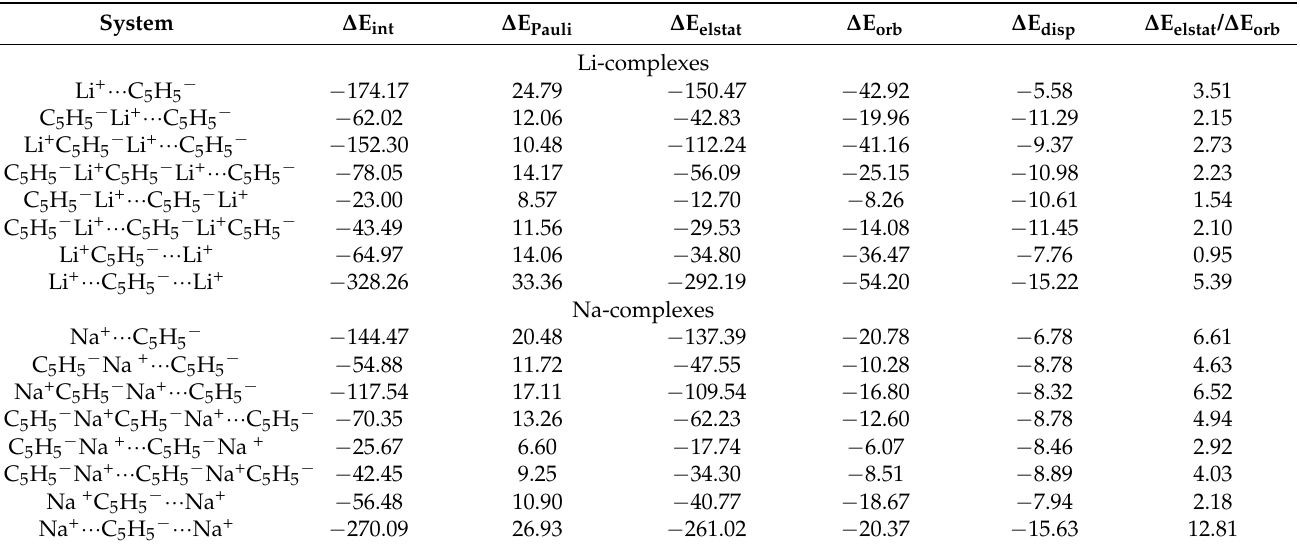
Table 1. The interaction energy terms (in kcal/mol) according to the scheme expressed by Equation (1); the ∆ E elstat / ∆ E orb ratio is also included. The decomposition scheme was applied for the lithium and sodium species for divisions of complexes indicated by three